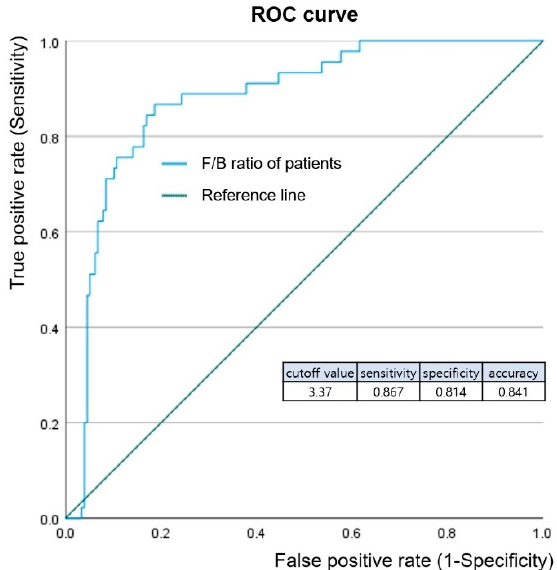
Figure 6. Receiver operating characteristic (ROC) curve analysis of F/B ratio. ROC curve analysis was conducted to diagnosis breast cancer through F/B ratio. The ROC curve of the F/B ratio showed a good distance between patients with breast cancer and healthy controls, with sensitivity of 0.867, specificity of 0.814, and accuracy 0.841.